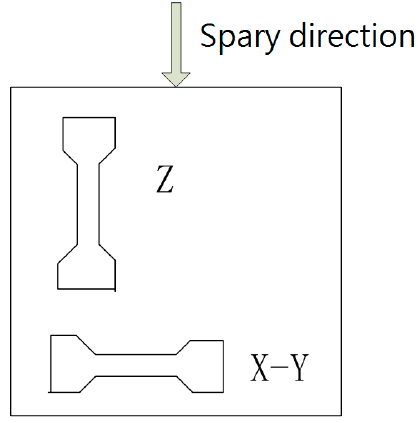
Figure 2. Diagram of the